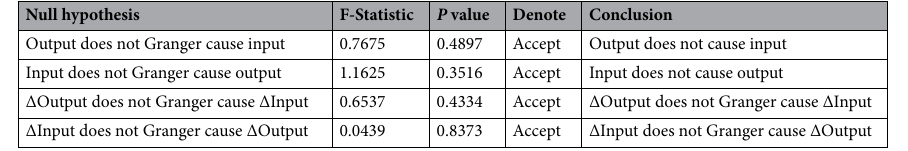
Table 8. Granger causality test results. ∆ denotes the first order series of this data.